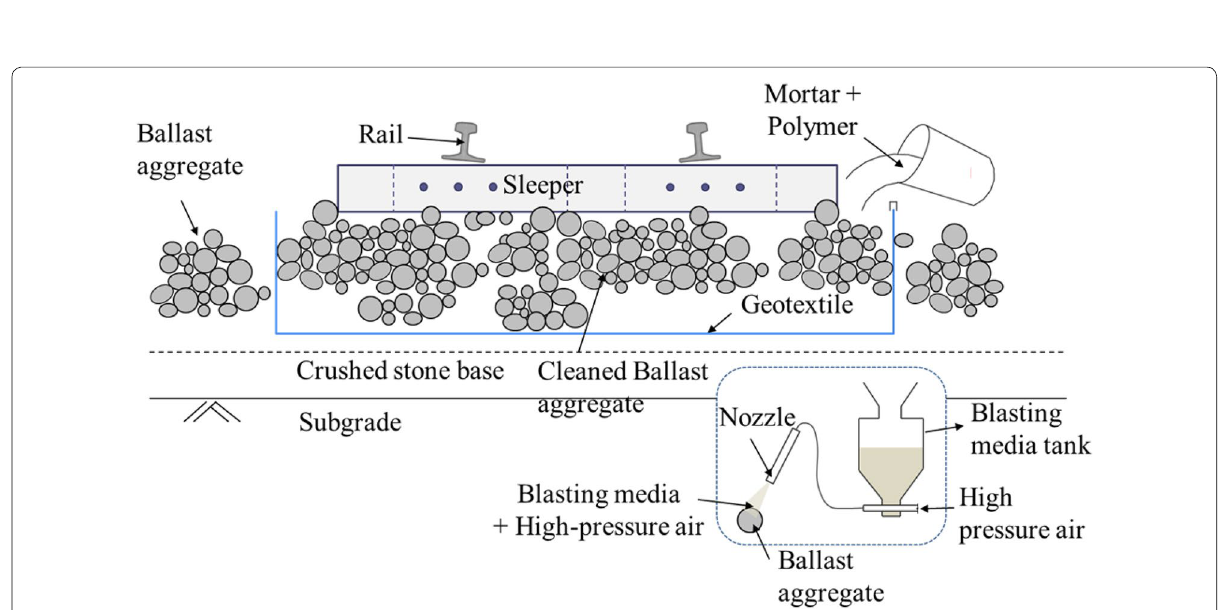
Fig. 2 Schematic illustration of the rapid-hardening concrete track